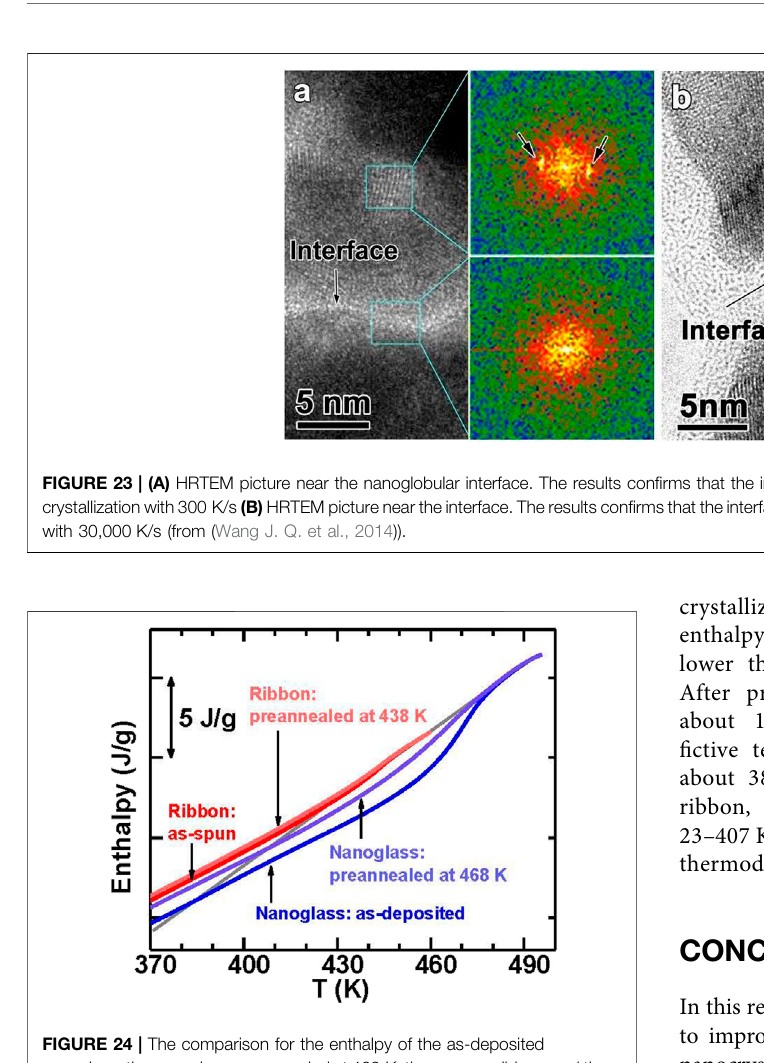
FIGURE 24 | The comparison for the enthalpy of the as-deposited nanoglass,thenanoglasspre-annealed at468 K,theas-spun ribbon,and the ribbon pre-annealed at 438 K. The extrapolation of the enthalpy for the supercooled liquid is marked by the solid grey line (from (Wang J. Q. et al.,